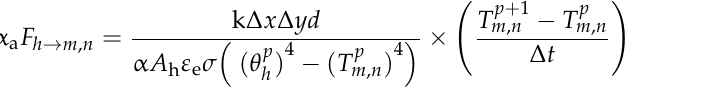
Figure 9. Reflected and absorbed radiation on opaque surface. Taking into account the thermoplastic’s low thermal conductivity and the low thermal loss through convection when the sheet’s temperature is low, by ignoring the conduction and convection parts in Equation (10) and using only one heater in the center of the sheet (heater number 8 in in Figure 6b) the product of the view factor between the elements of the sheet and the heater and the absorptivity of the sheet can be calculated at the initial heating time using Equation (14). The emissivity for the ceramic heater ( ε h ) in the setup is 0.92